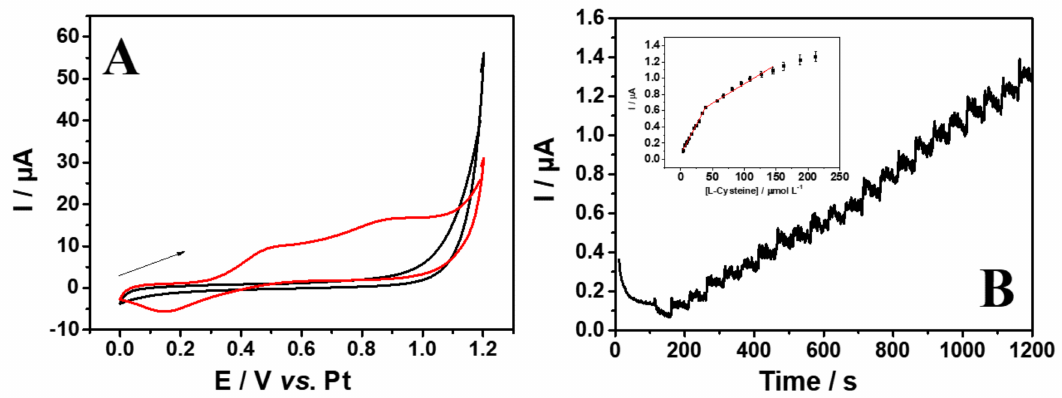
Figure 3. ( A ) Cyclic voltammograms in the presence ( — ) and absence ( — ) of 500 µ mol L − 1 L-Cys; scan rate of 50 mV s − 1 . ( B ) The analytical curve obtained by chronoamperometry for L-Cys (3.98 − 39.0 and 39.0 − 145 µ mol L − 1 ) by using the platinum electrode. Inset: Plot of peak current versus L-Cys. Applied potential of 0.55 V. Supporting electrolyte: 0.1 mol L − 1 PBS pH